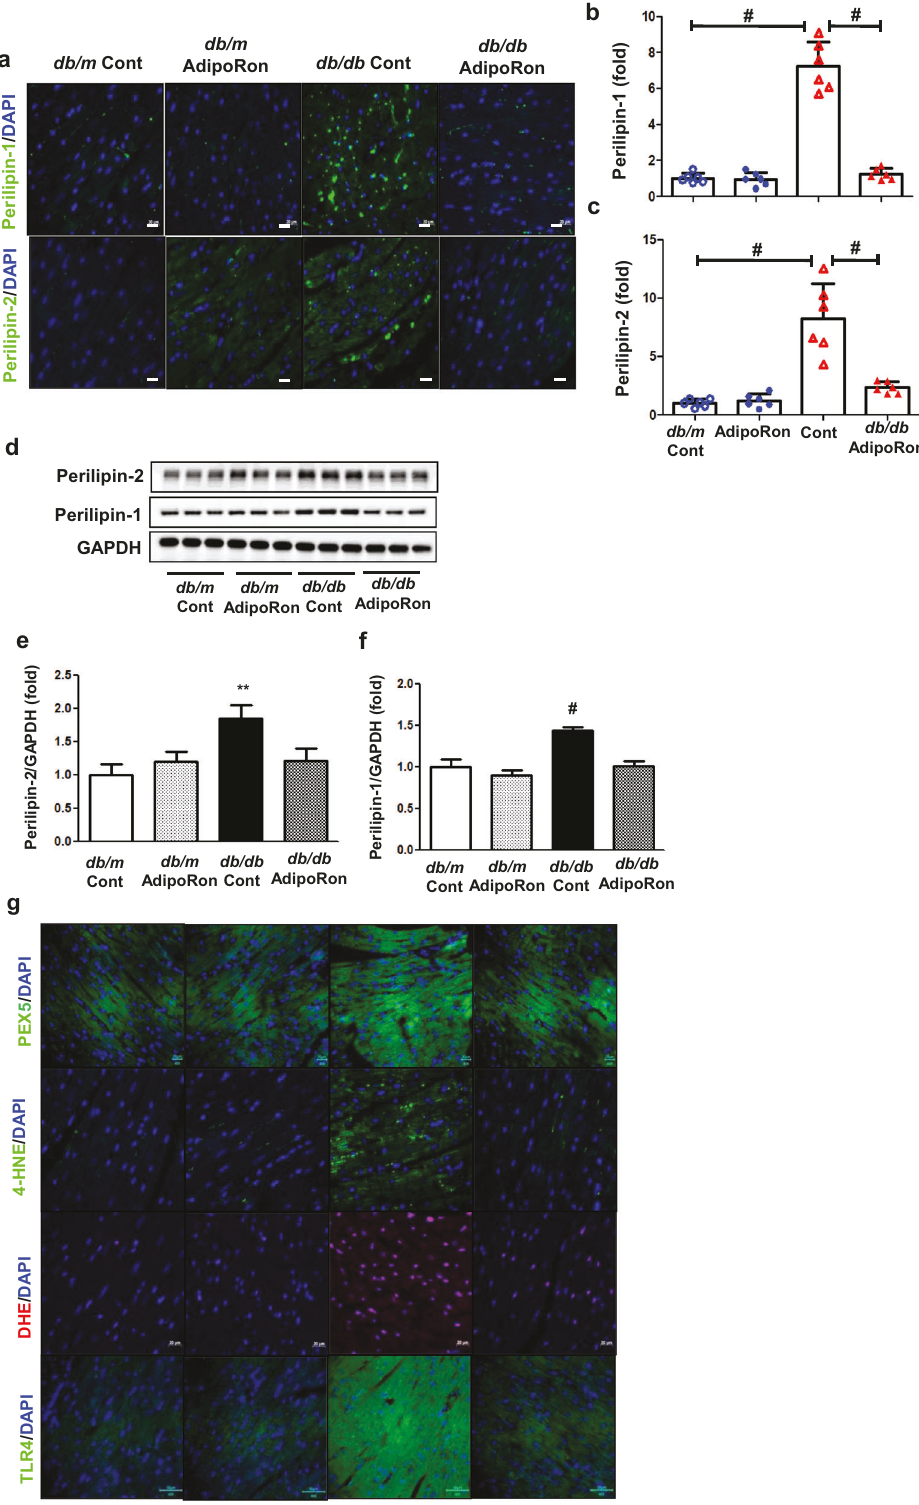
Fig. 3 Changes in ceramide metabolism and its associated pathways in diabetic and non-diabetic mice with or without AdipoRon treatment. a Representative images of immuno fl uorescence staining of perilipin-1/-2. b, c Quantitative analyses of perilipin-1/-2 according to groups. d Representative images of western blotting of perilipin-1/-2, and GAPDH levels. e , f Quantitative analyses western blotting images according to groups. g Representative images of immuno fl uorescence staining of PEX5, 4-HNE, DHE-positive cells, and TLR4 level ( h – k ) Quantitative analyses of immuno fl uorescence images according to groups. l Representative images of western blotting of TLR4 and GAPDH levels. m Quantitative analyses of TLR-4 expression according to groups. n – s Quantitative analyses of cholesterol, FFA, ceramide, acid ceramidase, sphingosine 1 phosphate, and PP2A activity in the cardiac tissues. * P <0.05, ** P <0.01, and # P < 0.001 compared with other groups. Scale bars, 20 μ m for perilipin-1/-2 (in a ) and 50 μ m for TLR4 (in